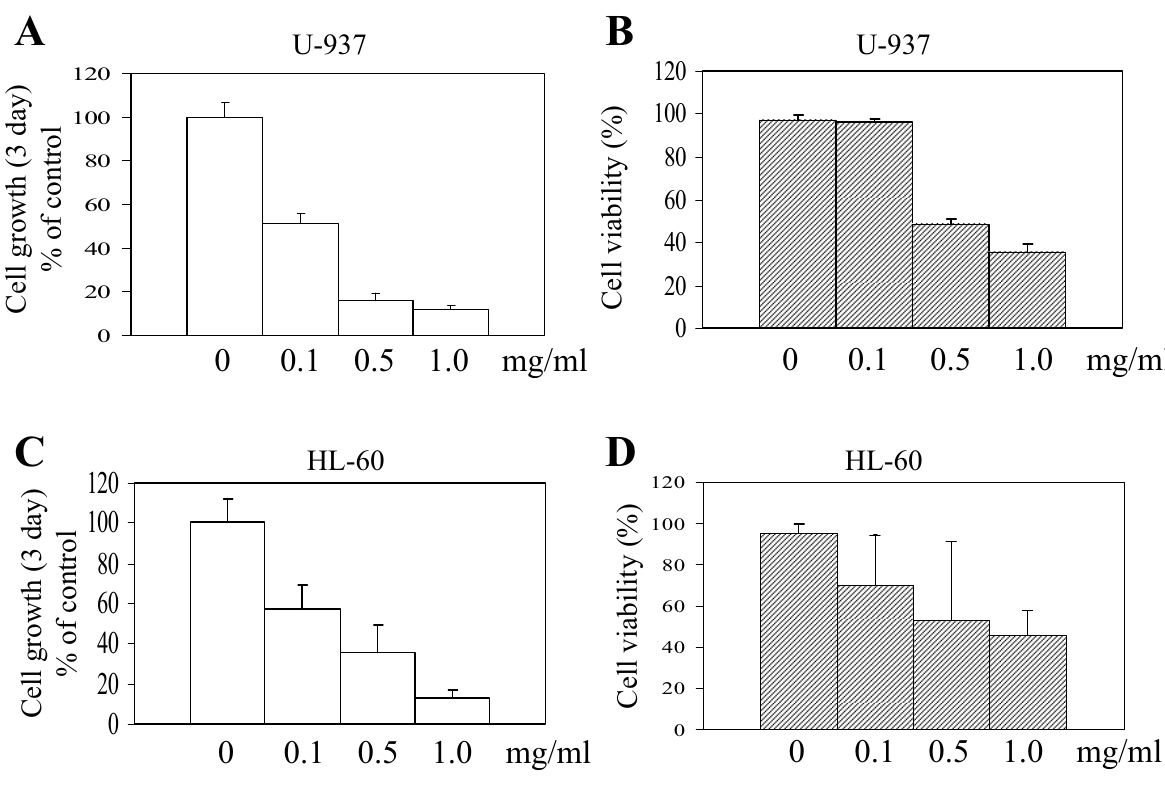
Figure 2 Control of cell growth and viability in U-937 and HL-60 cells by water extracts of I'm-Yunity™ (PSP). Both cell types were cul- tured and treated with different dose of I'm-Yunity™ (PSP) as described in Materials and Methods. Panels A and C show sup- pression of proliferation of U-937 (panel A) and HL-60 (panel C) cells by increasing concentrations of I'm-Yunity™ (PSP). Panels B and D show reduction of cell viability in U-937 (panel B) and HL-60 (panel D) by I'm-Yunity™ (PSP). Results in panels A-D represent average ± SD of 3–4 (Figure 2B) of water extracts of I'm-Yunity™ (PSP), sug- gesting that the polysaccharo-peptide exerts complex anti- cellular effects in the U-937 cells. Similar to our previous observations [28], treatment of HL-60 cells with the same dose range of water extracts of I'm-Yunity™ (PSP) was accompanied by a pronounced inhibition of cell growth and viability (Figure 2C and 2D).